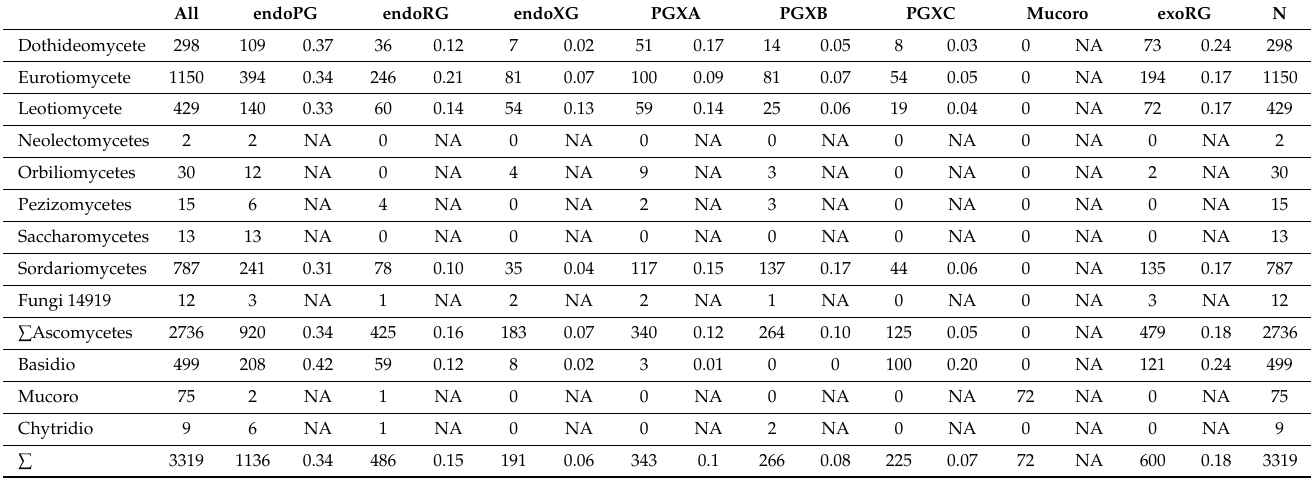
Table 1. Classification of fungal GH28 homologues. Indicated are numbers (n) of subfamily homologues per taxon and the proportion with respect to the total number (N) of homologues. NA: Not applied (sets with N < 100). Classification is based on the tree topology, not HMMERCTTER